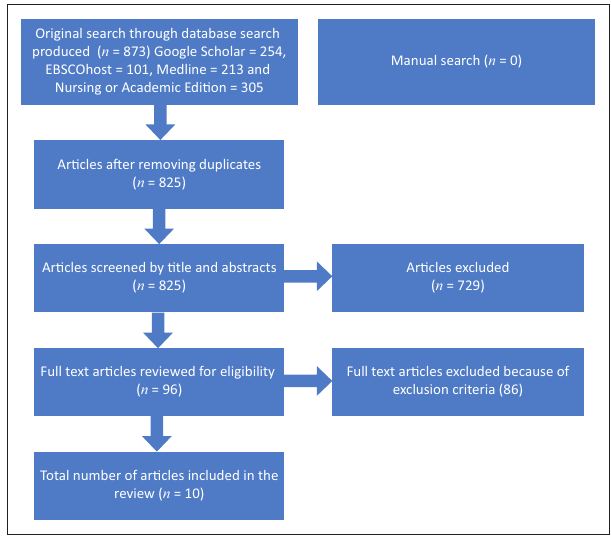
FIGURE 1: PRISMA flow chart of the search